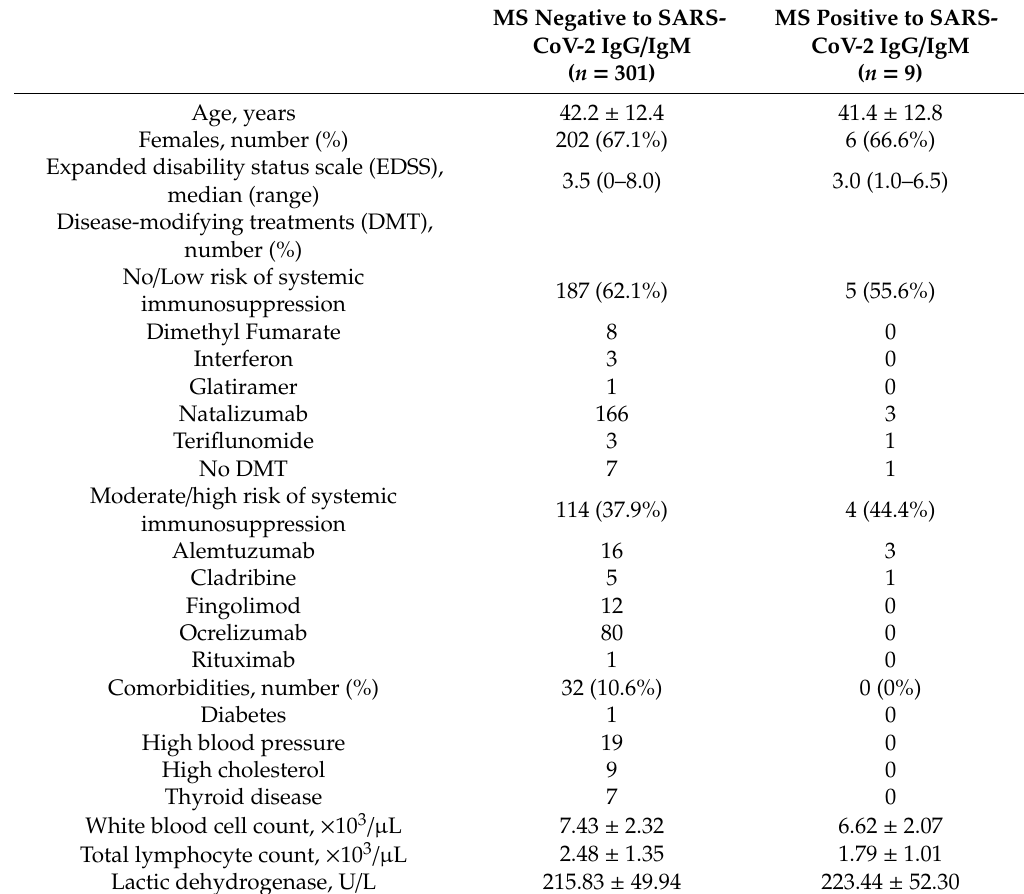
Table 2. Demographics, clinical features, treatments, and laboratory findings of MS